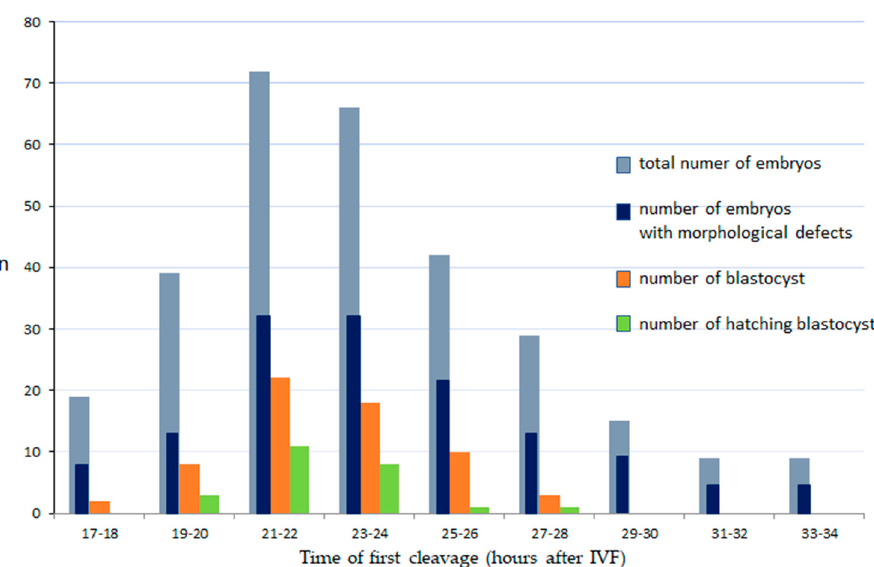
Figure 1. The relationship between the time of first cleavage, incidence of morphological defects and development of domestic cat embryos. IVF: in vitro fertilization. Number of cleaved embryos, blastocyst and hatching blastocysts: there were statistically significant differences between those with first cleavage at 21–24 hpi and other time intervals ( p < 0.001).